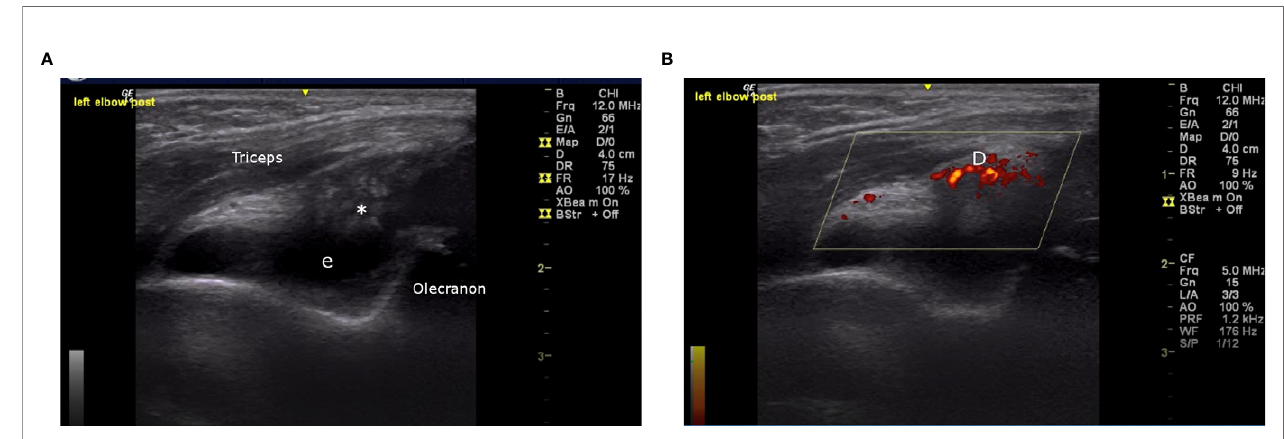
FIGURE 7 | (A) Left elbow, posterior longitudinal view, greyscale (10 year old male, Case 6), demonstrating dense proliferative synovitis (*) in olecranon fossa with effusion (e). (B) Left elbow, posterior longitudinal view, color Doppler (10 year old male, Case 6), demonstrating intense Doppler signal (D) in olecranon